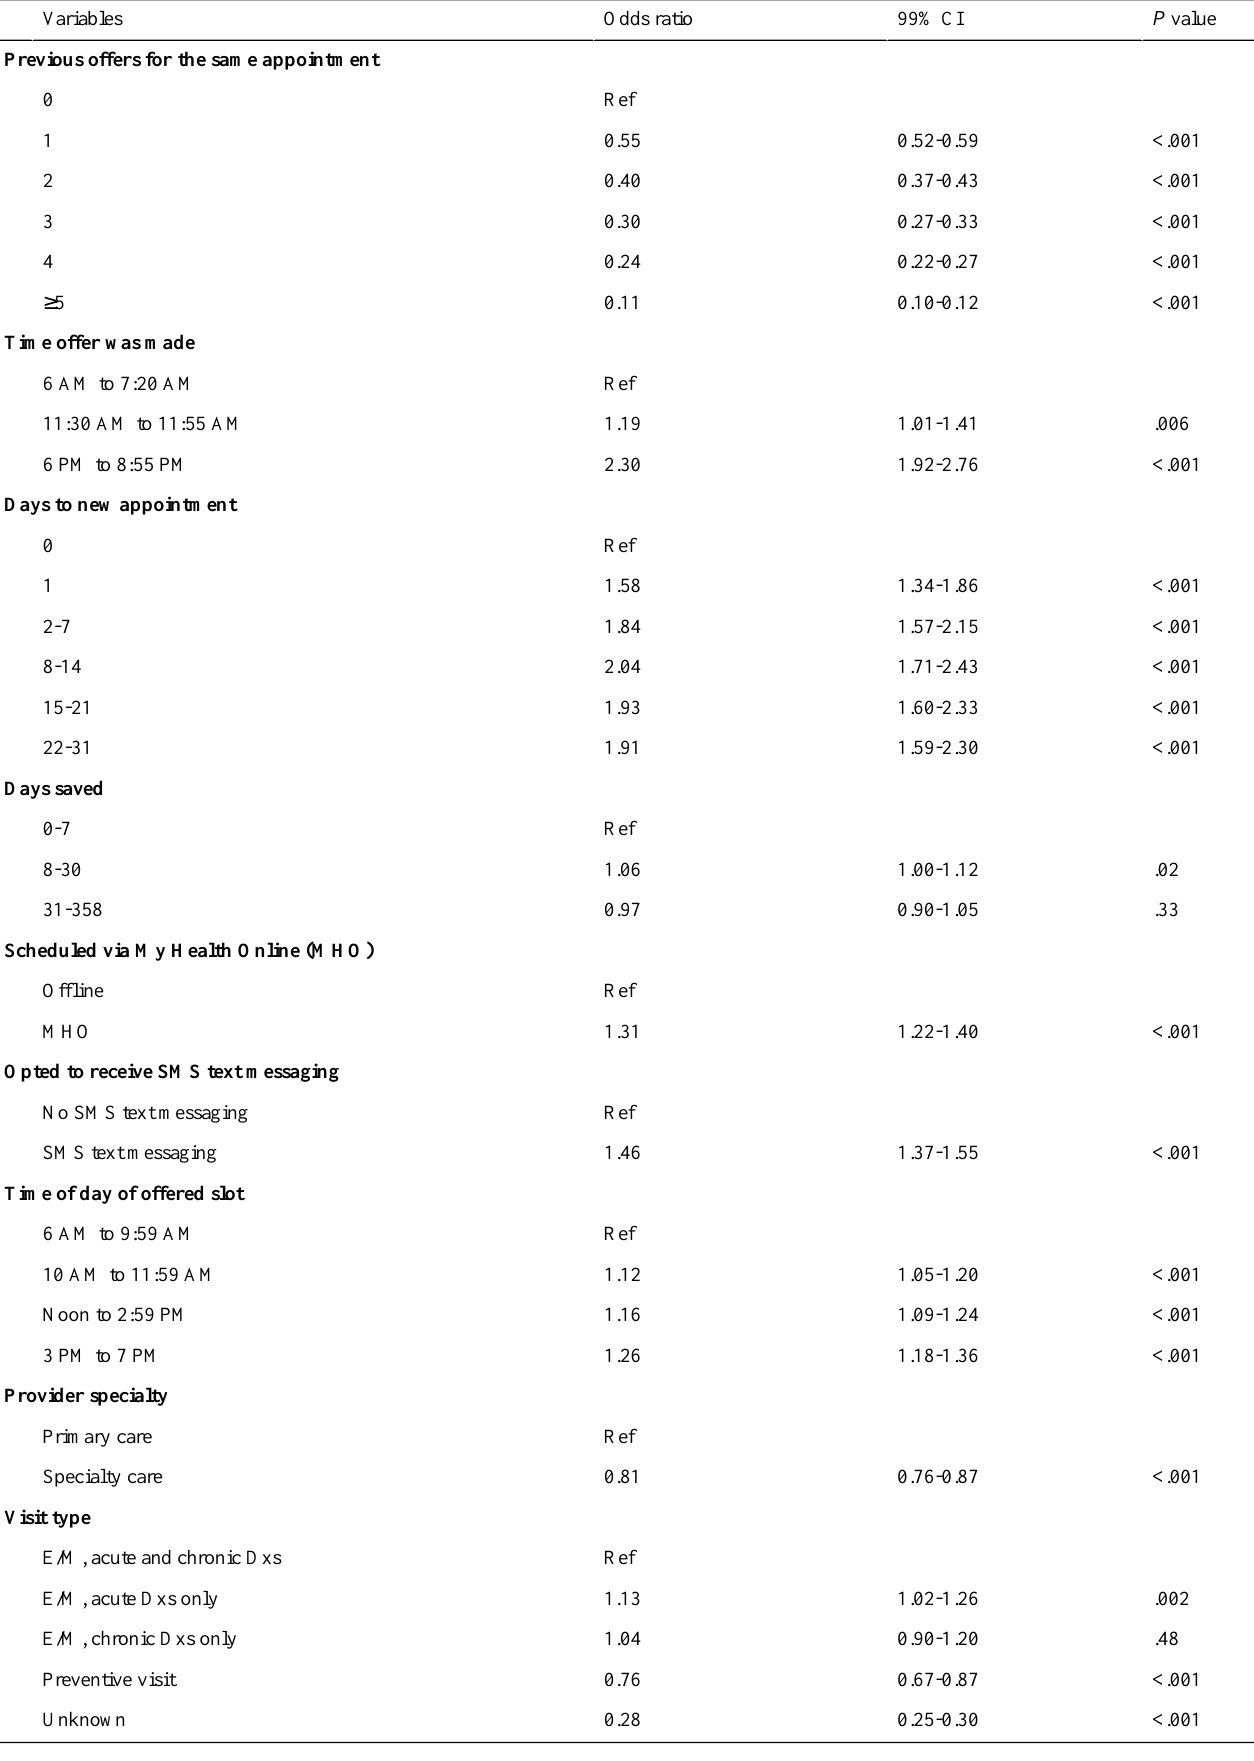
Table 3. Predictors of Fast Pass offer acceptance from a logistic regression (N=176,615) a .